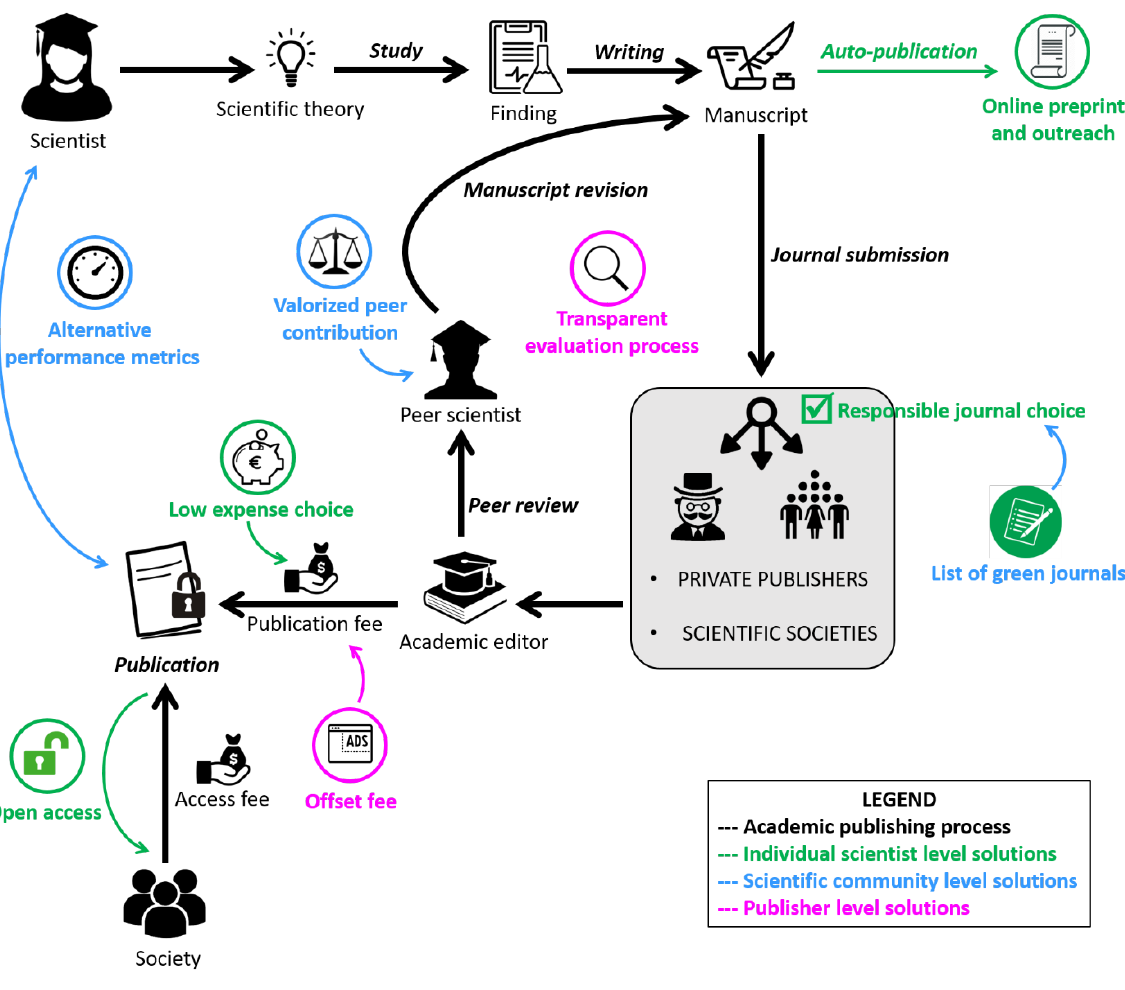
Figure 2 The current academic publishing process (black arrow path) and key solutions for improvements at the individual scientist (green), scientific community (blue), and publisher (purple)